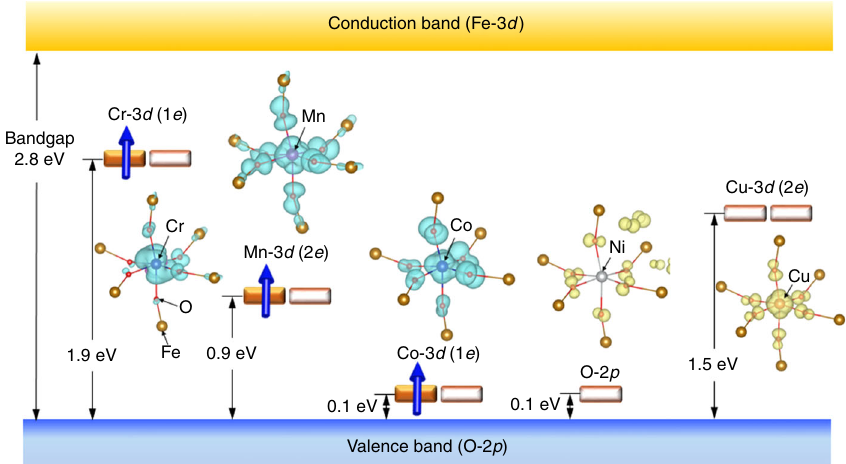
Fig. 1 Wave functions and schematic electronic structures of transition metal (TM = Cr, Mn, Co, Ni and Cu)-doped BFO obtained from DFT calculations. The bandgap ( E g ) of BiFeO 3 (BFO) is calculated to be 2.8 eV. The valence band maximum (VBM) is primarily formed by O-2 p , and the conduction band minimum (CBM) is formed by Fe-3 d . Filled and open rectangles indicate electron- fi lled and electron-unoccupied states, respectively. The e states of Cr, Mn and Co are half- fi lled with electrons, while the e state of Cu is empty. The blue arrows designate spin-polarized electrons in the gap states. Except for TM = Ni, the gap states are derived from the 3 d orbitals of TMs hybridized with the surrounding O-2 p . For TM = Ni, the 3 d -derived fi lled states are present below the VBM, and the unoccupied O-2 p state appears just above the VBM, showing Ni 2+ with a ligand hole in the O-2 p state (see text). The wave functions of each gap state are visualized. The wave functions coloured in blue feature orbitals fi lled with electrons, and those in yellow present empty orbitals, where the iso-surface level remains constant for displaying the wave functions. The 3 d orbitals of TMs are hybridized with the O-2 p of the surroundings in different manners re fl ecting their interactions. The 1 e state of TM = Cr and Co shows π * bonding having d xy and d x 2 − y 2 characters, while the 2 e state of TM = Mn and Cu exhibits σ * bonding featuring d yz and d zx